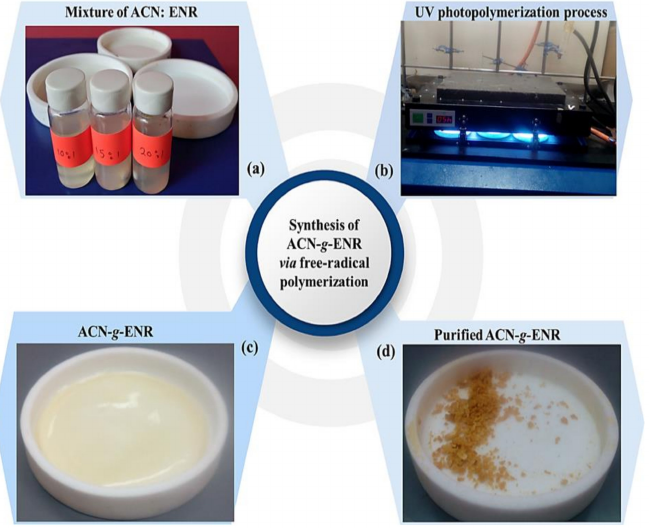
Figure 2. Synthesis of isoprene–acrylonitrile radical (ACN- g -ENR) at different mole ratios via